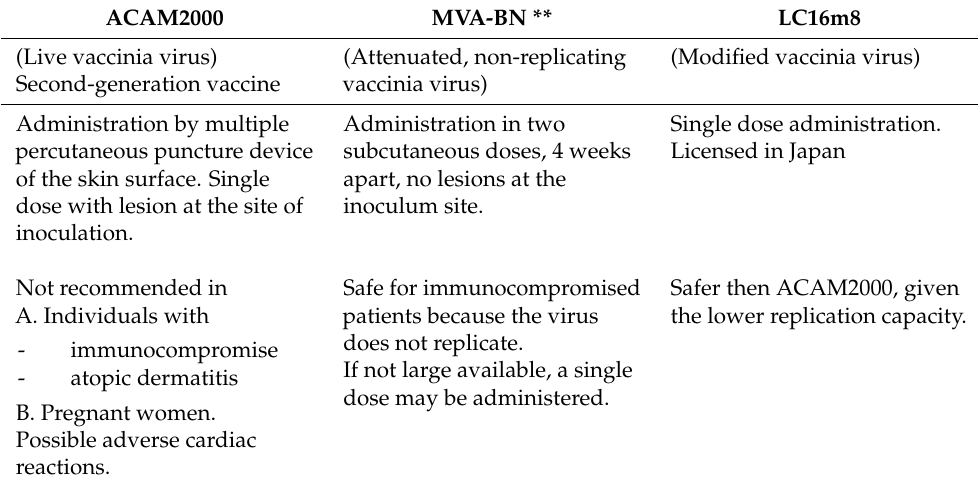
Table 2. Synopsis of the Smallpox vaccines that can currently be used against